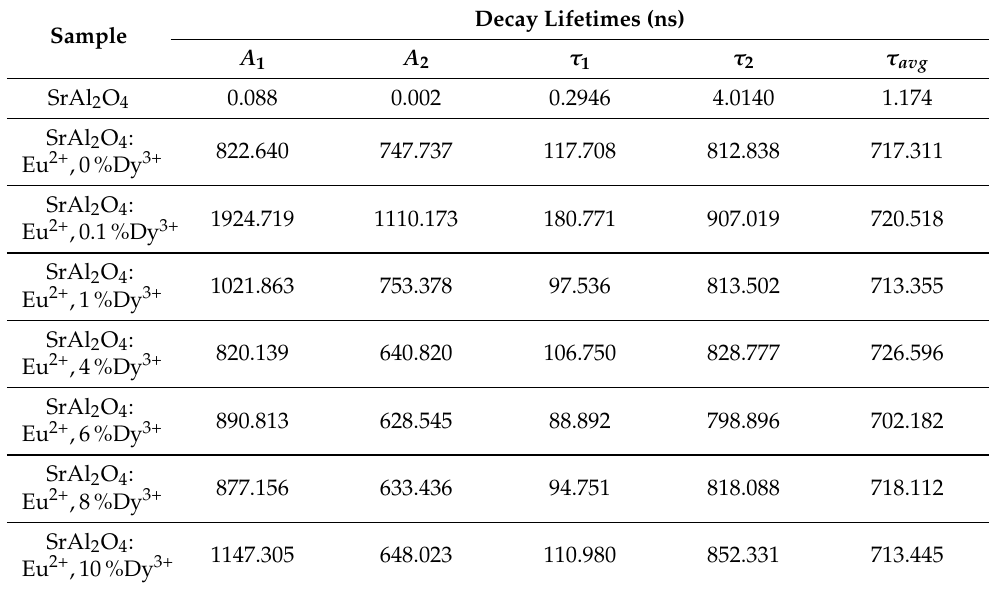
Figure 10. ( a ) Fluorescence lifetime decay curve and fitting curve of SrAl 2 O 4 , ( b ) Fluorescence lifetime decay curves of different samples of SrAl 2 O 4 : 0.02Eu 2+ ,xDy 3+ (x = 0, 0.001, 0.01, 0.04, 0.06, 0.08, and 0.1), ( c ) Fluorescence lifetime decay fitting curves for different samples of SrAl 2 O 4 : 0.02Eu 2+ ,xDy 3+ (x = 0, 0.001, 0.01, 0.04, 0.06, 0.08, and 0.1). Table 1. Parameters of fluorescence lifetime decay curves for different